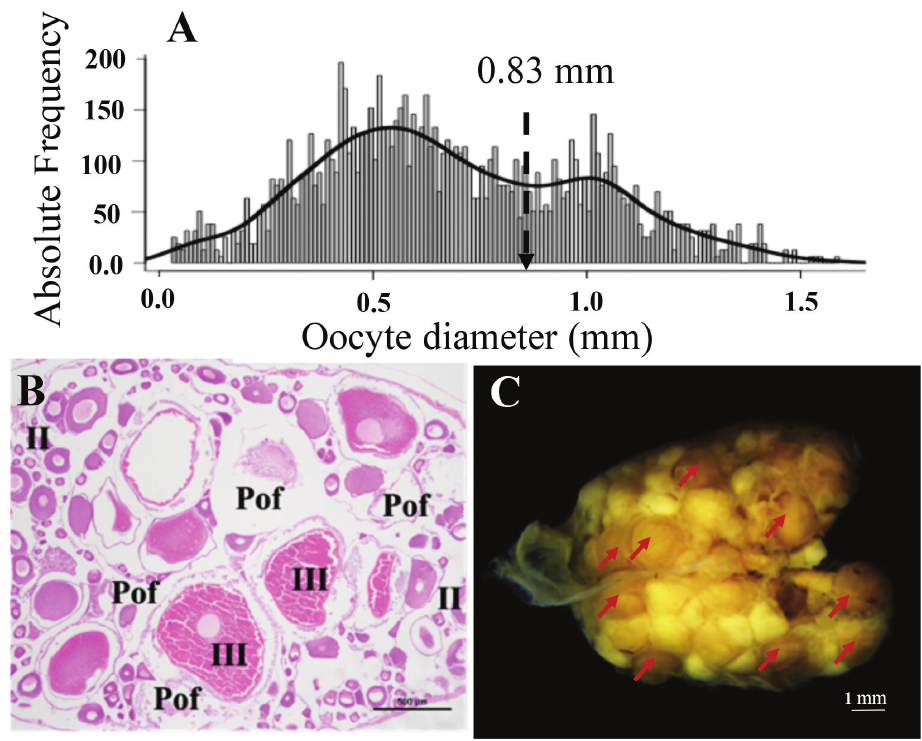
FIGURE 4 | A. Variation in the diameter of the oocytes collected from 11 mature Helogenes marmoratus females collected from a catchment of River Guamá in Capitão Poço, Pará State, Brazil. The dashed black arrow indicates the minimum diameter of the mature oocytes. B. Photomicrograph of spawned female with oocytes in different stages of maturation: II, stage II oocyte; III, stage III oocyte; Pof: Post- ovulatory follicle. C. Ovary with mature oocytes (red